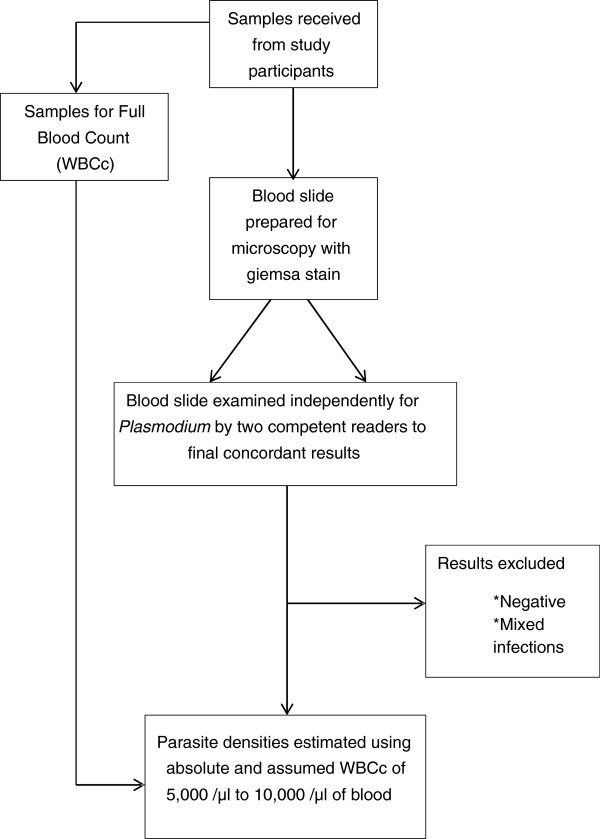
Flow chart of sample processing and results analysis forPlasmodium falciparumdensity estimation.